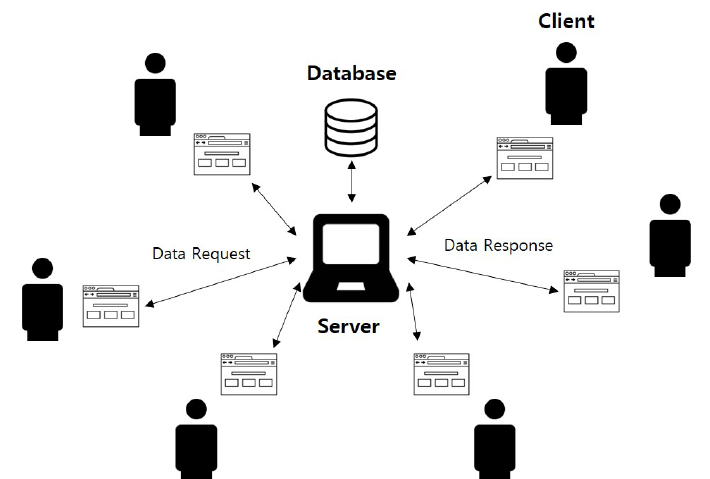
Figure 5. Structure of the centralized server-client model.